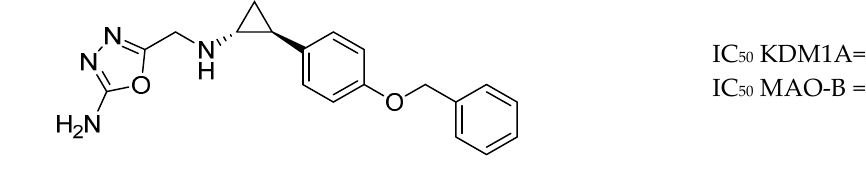
Figure 18. Vafidemstat (ORY-2001).